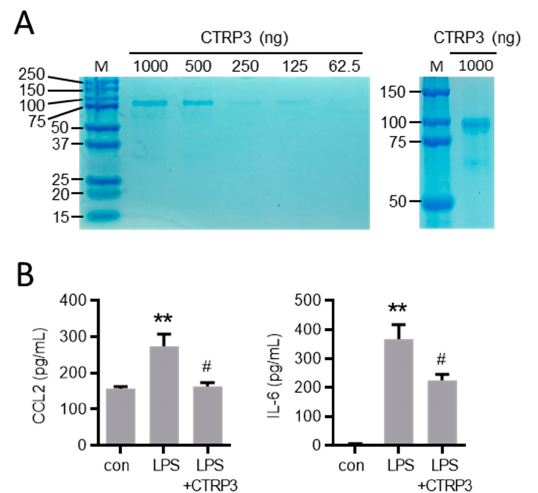
Figure A1. Characterization of recombinant CTRP3. ( A ) Indicated quantities of recombinant CTRP3 (C1q/TNF-related protein 3) were run on SDS-PAGE (left) and 1000 ng CTRP3 for a longer gel run (right). Gels were subsequently stained with Coomassie. M = protein size marker. ( B ) THP-1 monocyte-like cells were stimulated with LPS (10 ng/mL) alone or pretreated with CTRP3 (10 µg/mL, for 30 min) and with CTRP3 alone for 18 h. CCL2 (C-C motif chemokine ligand 2) and IL-6 (interleukin-6) protein levels in the cell supernatant were analyzed by ELISA ** p < 0.01 vs. con = unstimulated control, # p < 0.05 vs. LPS, n = 5–6.